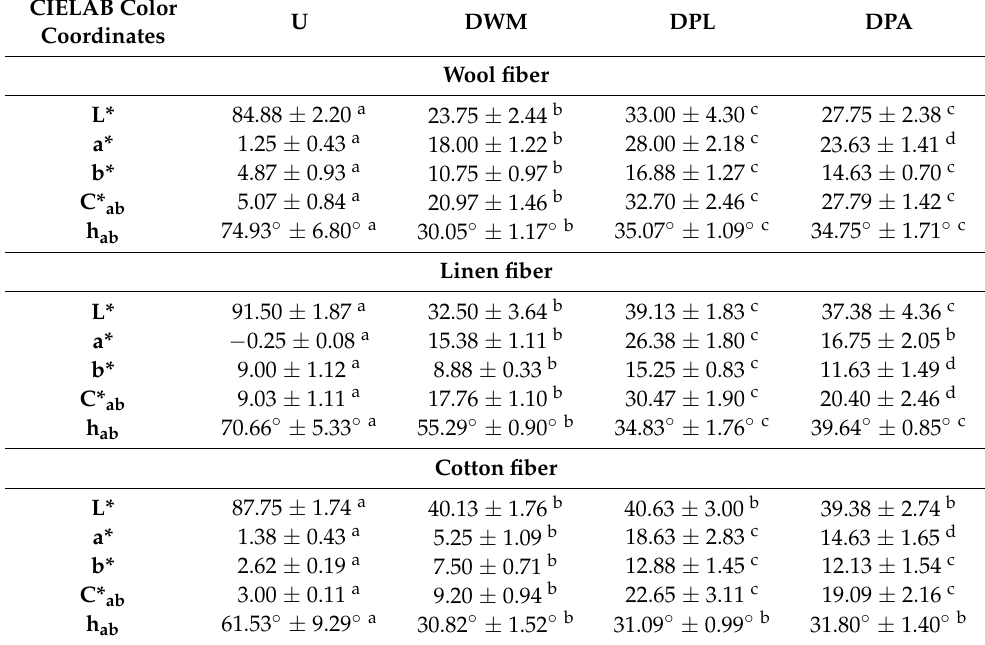
Table 8. Colorimetric data. CIELAB color coordinate values (CIELAB units) of discs cotton, linen and wool fibers colored using the dye extract. Different superscripts letters indicate significant differences between treatments (U, DWM, DPL and DPA) at p < 0.05 (Tukey